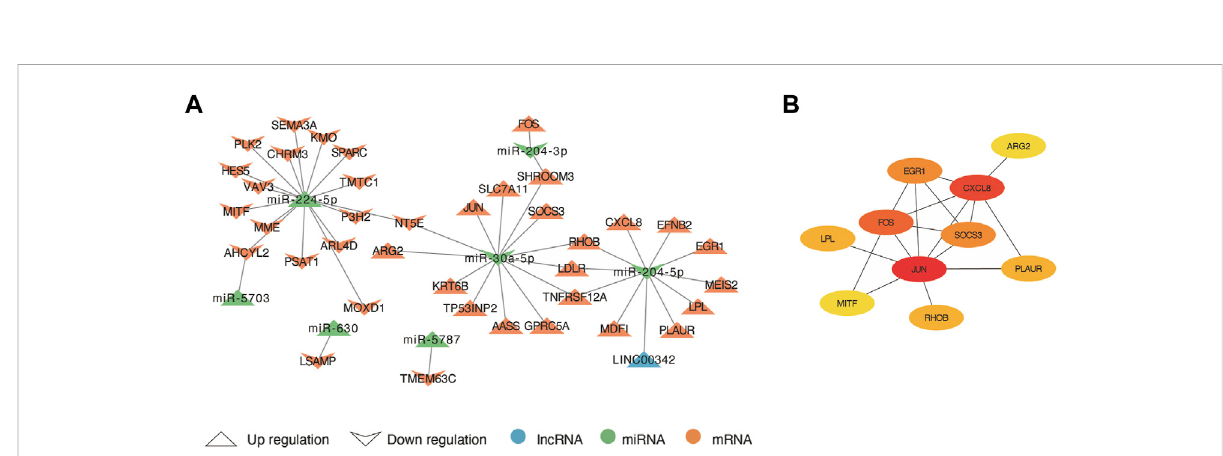
FIGURE 6 The lncRNA-miRNA-mRNA competing endogenous RNA (ceRNA) network and hub genes. (A) The arrow up triangle indicated upregulation genes in AAK patients; The arrow down triangle indicated downregulation genes in AAK patients; The blue represented lncRNAs; The green represented miRNAs; The orange represented mRNAs. (B) The hub genes were selected from the ceRNA network using the MCC